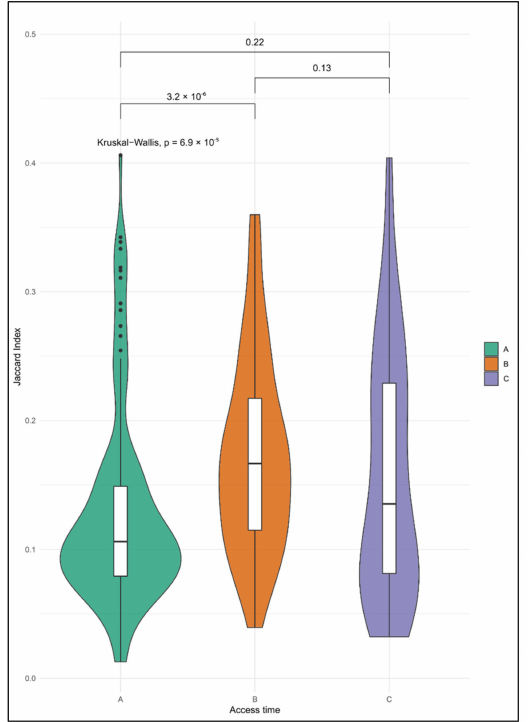
Figure 3. Violin plots showing the distribution of the Jaccard Indexes (JIs) computed by comparing the copy number alteration (can) profile of single circulating tumor cells (CTCs) and control at the access times ( A ) ( n = 24), ( B ) ( n = 13) and ( C ) ( n =